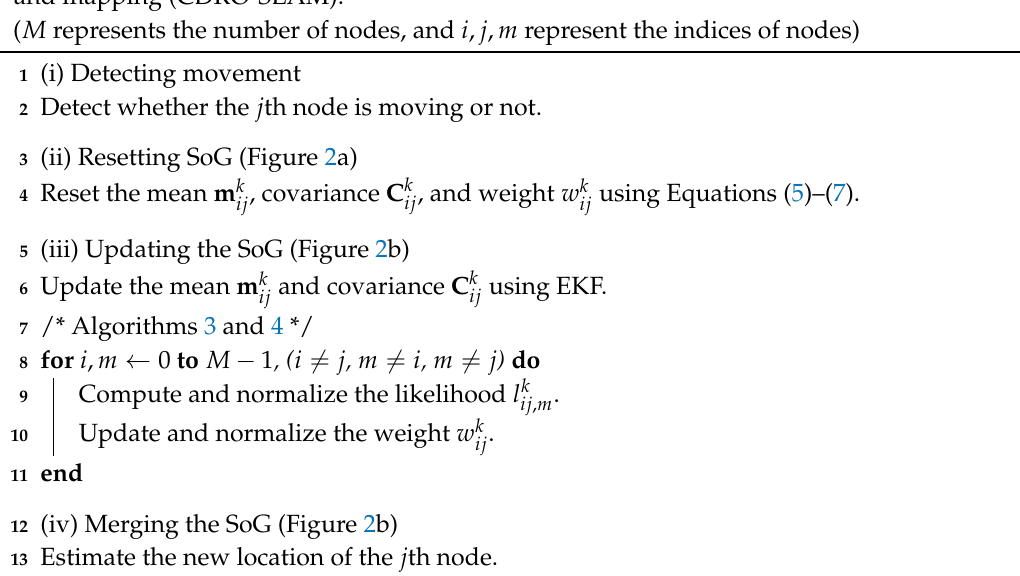
Algorithm 2: Moving stage of the cooperative dynamic range-only simultaneous localization and mapping (CDRO-SLAM).